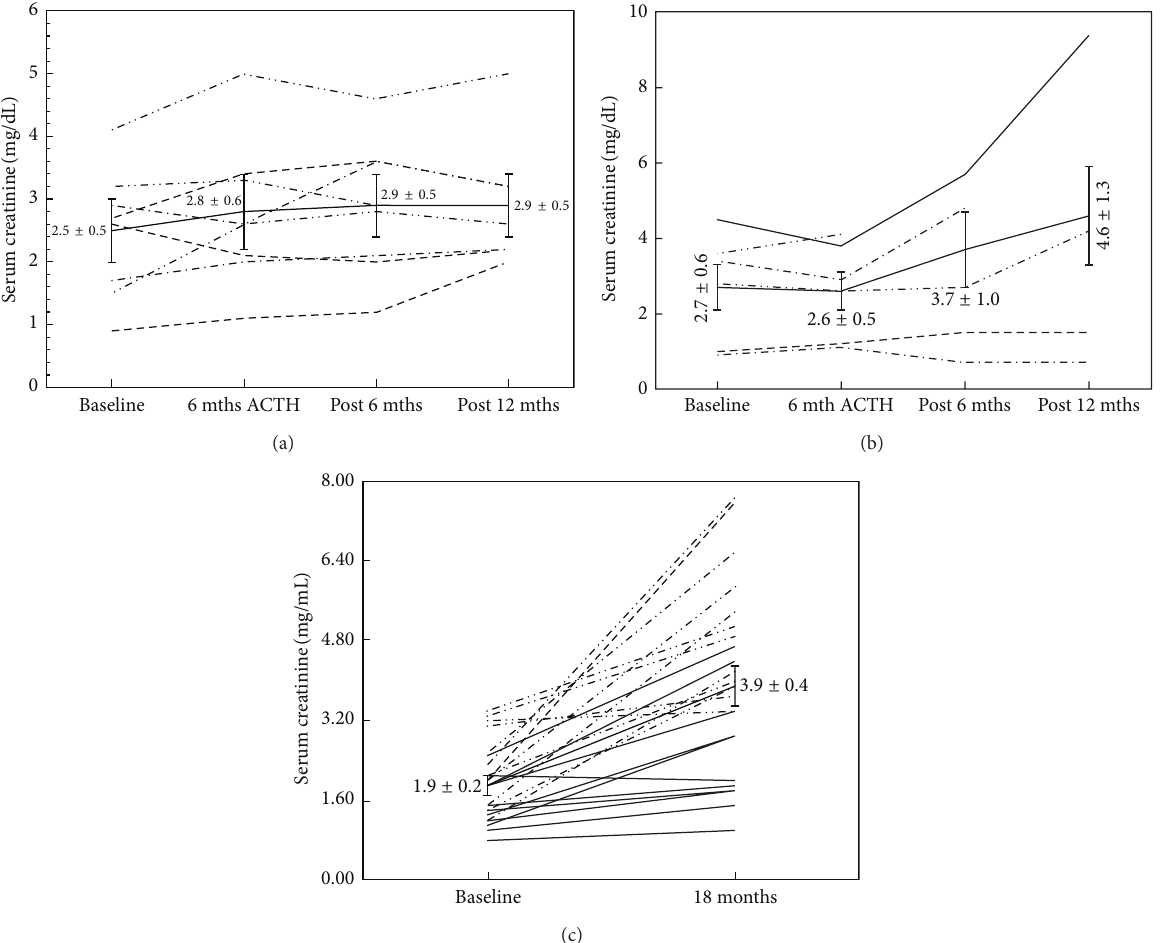
Figure 4: (a) The change in serum creatinine for patients randomized to the 16-unit dose from baseline to 12 months of completion of ACTH therapy. There was no significant change in average serum Cr. A single patient from this group developed ESRD within 17 months. (b) The change in serum creatinine for patients randomized to the 32-unit dose from baseline to 12 months of completion of ACTH therapy. There was a trend toward increased Cr at 12 months, but this difference did not reach statistical significance. Three of six patients in this group developed ESRD within 14.3 months. (c) The change in serum creatinine for age-matched diabetic controls not receiving ACTH therapy. Serum Cr significantly increased ( 𝑃 = 0.001 ) over 18 months. Of the 23 patients, 12 reached ESRD within 18